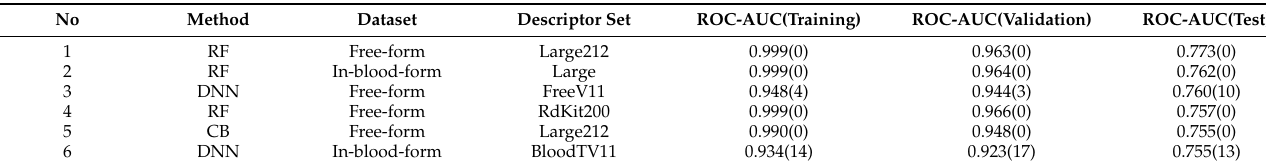
Table 3. Top six single models.